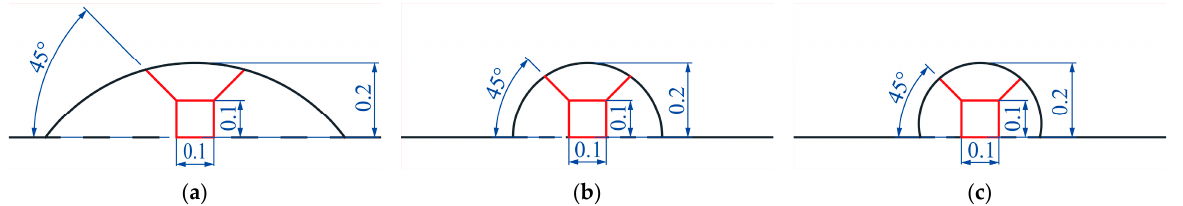
Figure 3. Computational domain and mesh distribution.